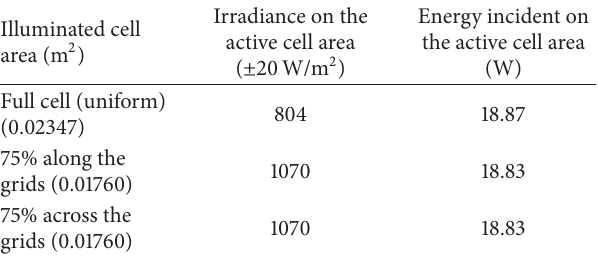
Table 2: Irradiance and energy flux incident on the active cell area for uniform and nonuniform illumination